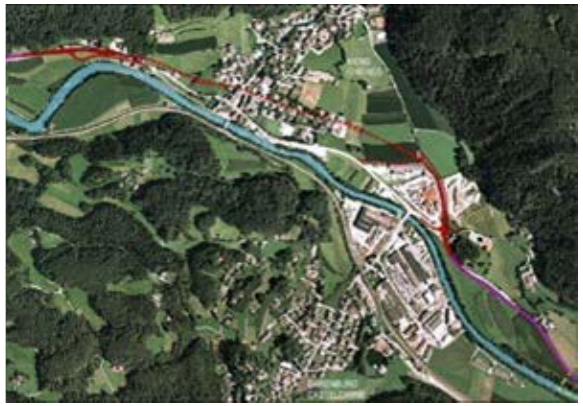
Figure 3. The longitudinal axis (red line) of the new tunnel to by-pass the village of